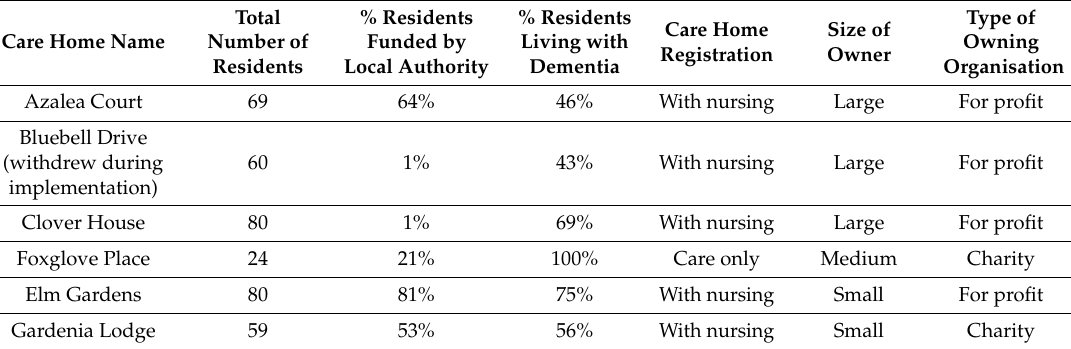
Table 2. Characteristics of participating care homes.